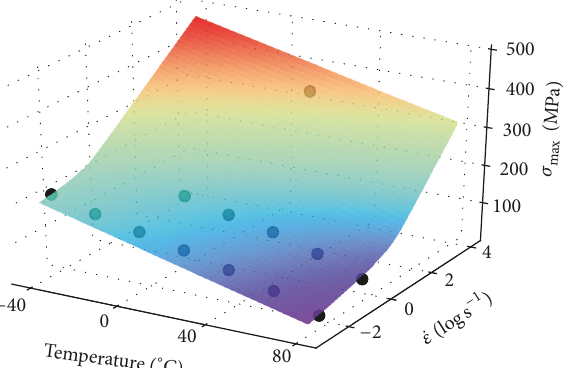
Figure 5: Failure stress as a function of strain rate and temperature accordingtotheRee-Eyringlaw.Experimentaldataisplottedasdark